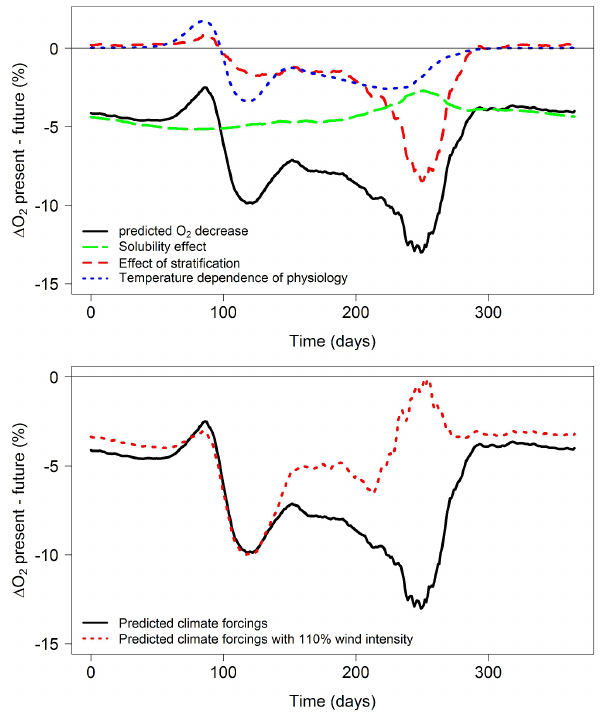
Fig. 10. Top panel shows predicted percentage decrease of oxygen concentration at 50m depth between present (period 2000–2010) and future (period 2090–2100), partitioned amongst different fac- tors: solubility, physical factors (stratification) and the effect of tem- perature dependence on the physiology. The curves show the aver- age of 16 simulations. Bottom panel shows a comparison between the decrease in oxygen concentration at 50m depth using the pro- jected future forcings and future forcings with 110% wind